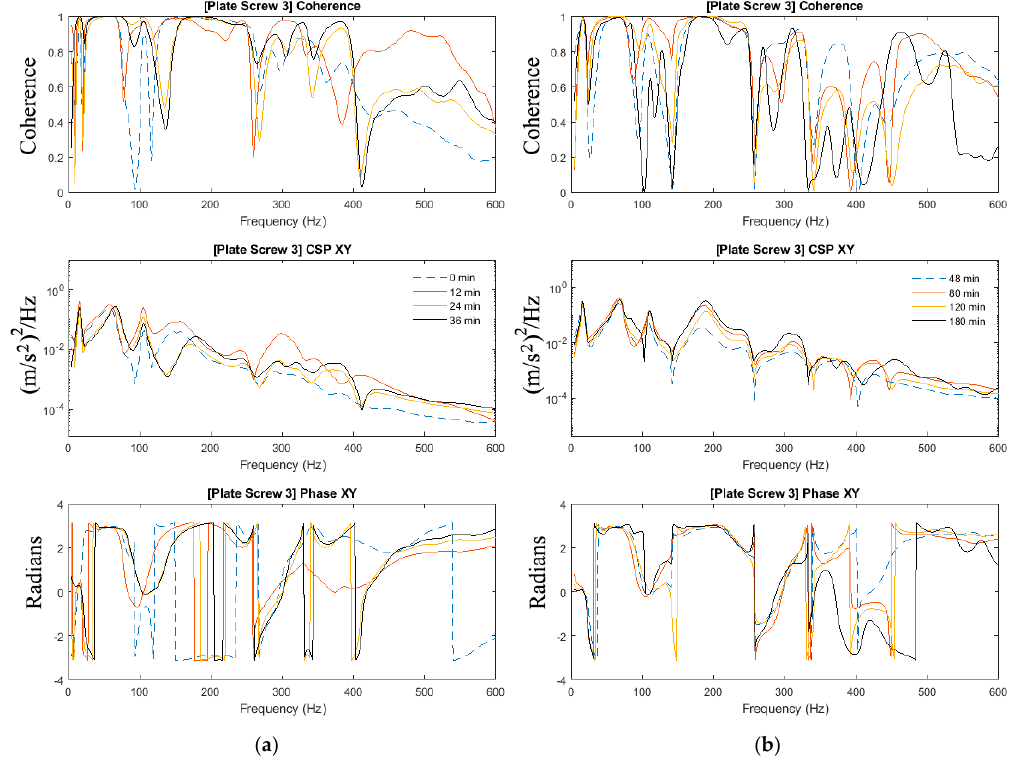
Figure 9. Coherence, cross-spectra and phase functions of Test #3 experimental investigations; ( a ) from 0 to 36 min and ( b ) from 48 to 180 minutes.